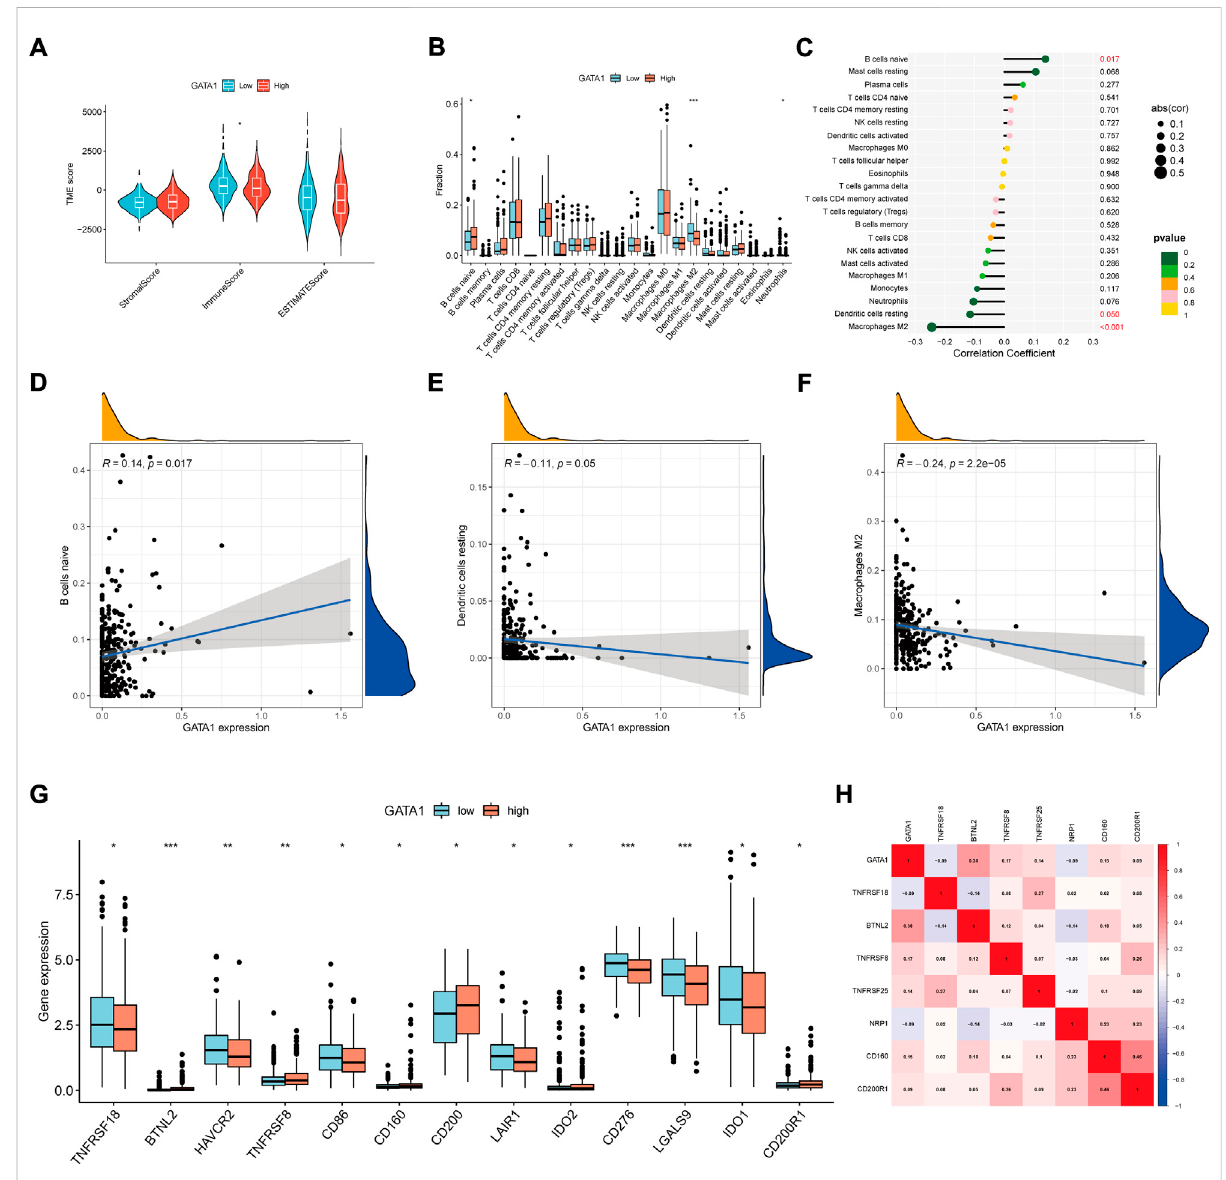
FIGURE 6 Tumor microenvironment and immune correlation analysis: (A) Distribution of stromal, immune, and total scores in tumor microenvironment between high and low expression groups; (B) Analysis of immune cell in fi ltration in high and low expression groups; (C) Correlation between GATA1 and immune cells for analysis; (D – F) Relationship between GATA1 and Bcells naïve, Dendritic cells resting, and Macrophages M2 expression; (G) Box line plot of immune checkpoint gene scores in high and low expression groups; (H) Co-expression relationship between GATA1 and immune checkpoint